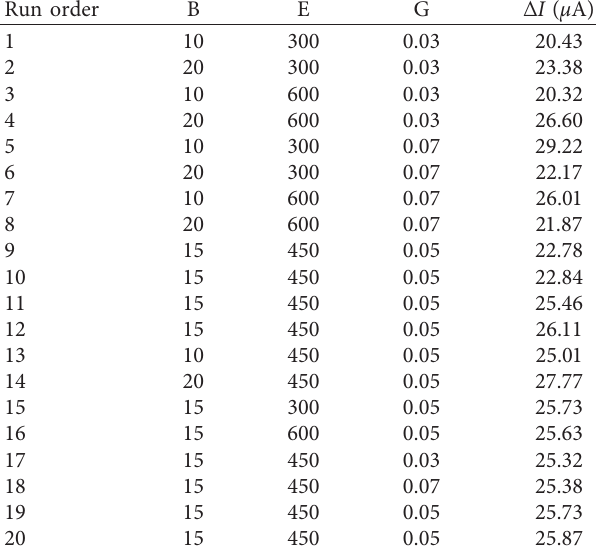
(Figure 4), with a linear regression equation: